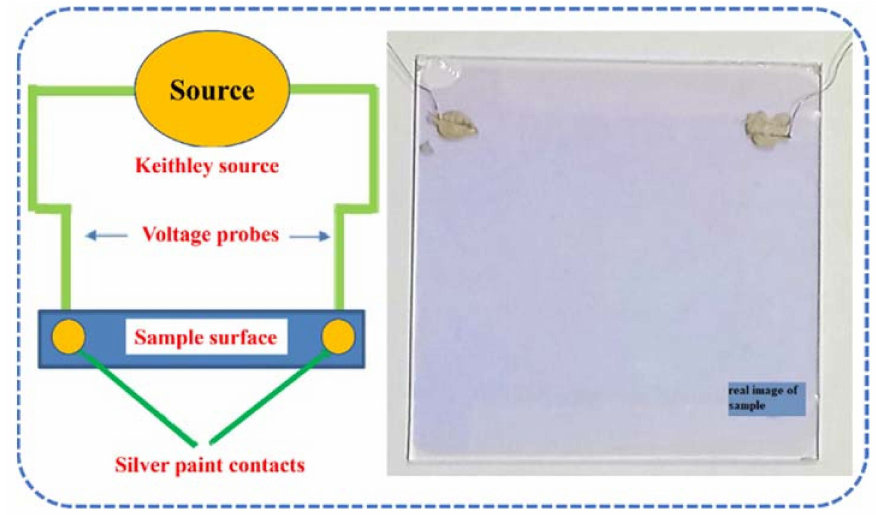
Figure 1. Schematic of two-probe conductivity method with real image of the